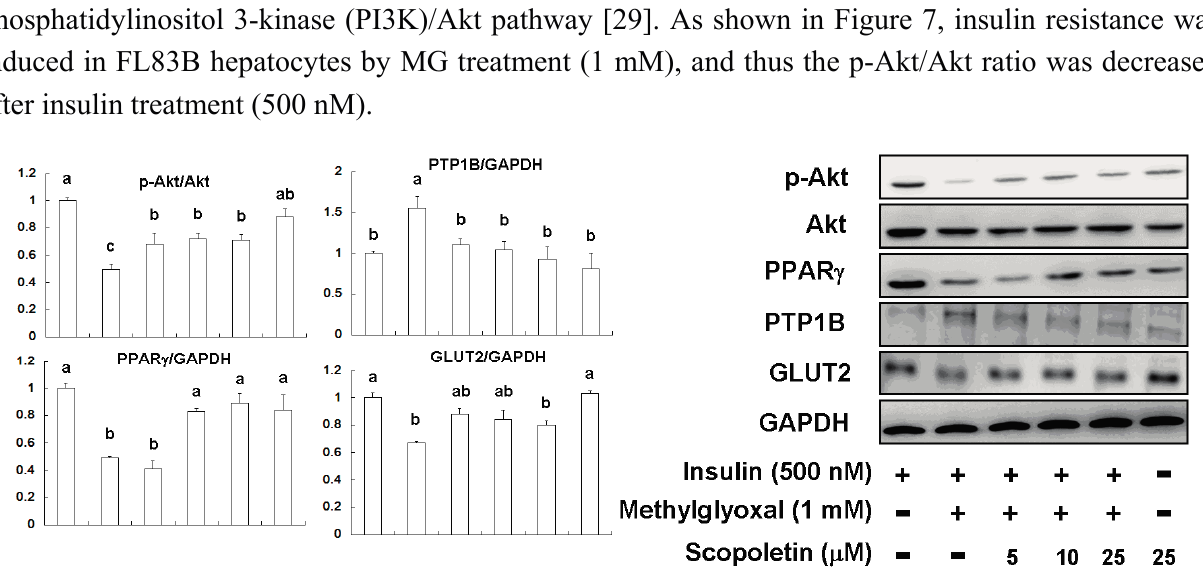
Figure 7. The effects of scopoletin (SP) on Akt phosphorylation, PPAR γ , PTP1B, and GLUT2 in MG-induced FL83B hepatocytes. Data were shown as mean ± SD ( n = 3). (a–c) indicate statistically significant differences p <